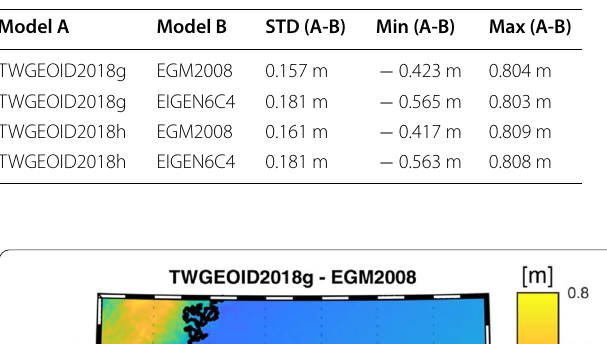
Table 7 Statistics on the residuals of the comparison of the TWGEOID2018 geoid model (gravimetric and hybrid versions) with respect to EGM2008 and EIGEN6C4 global models (over the Taiwan area)